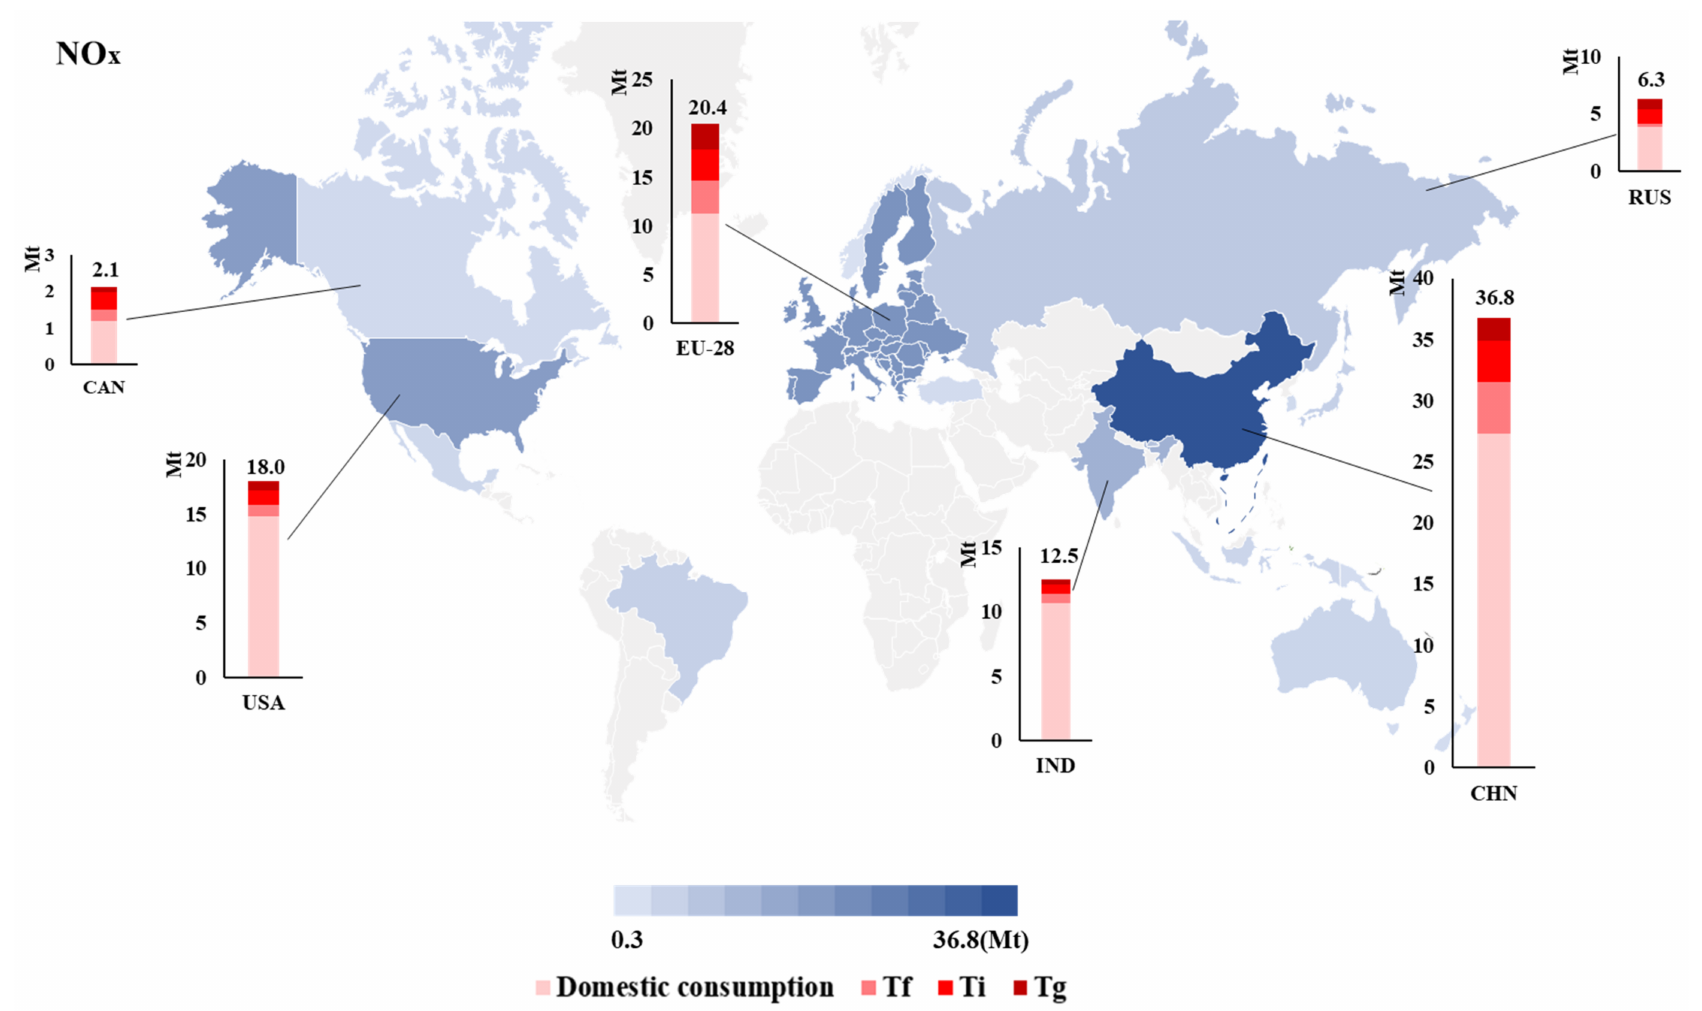
Figure 3. The situation of global pollutants emissions in 2014. Fifteen major regions are selected. See Appendix A Tables A1–A4 for detailed